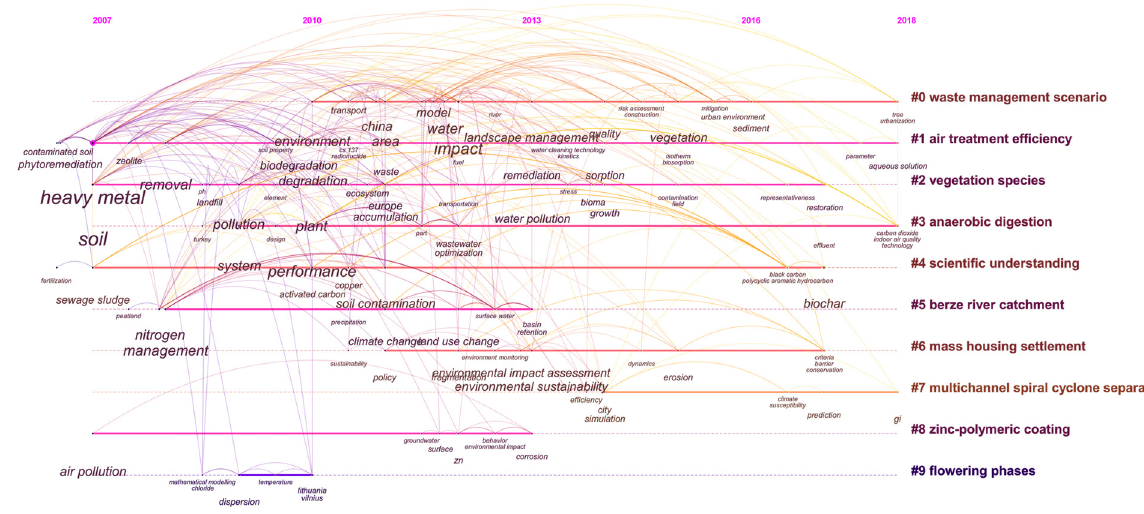
Figure 10. The timeline view of keywords for the JEELM